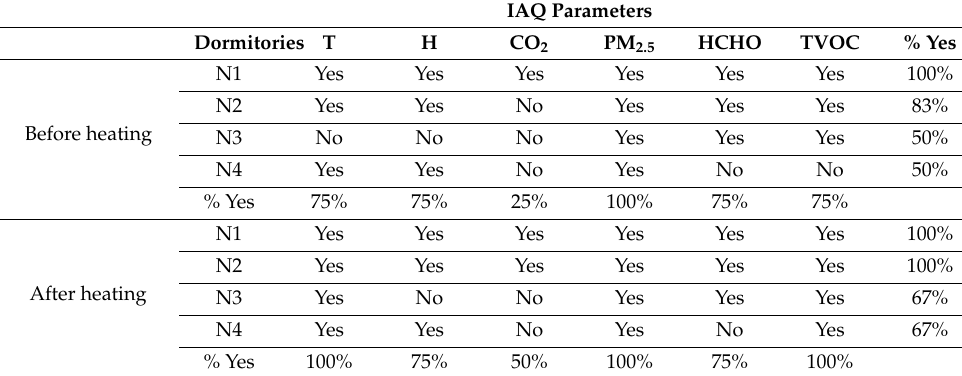
Table 5. Compliance of IAQ for parameters in the studied dormitories with China standard. “Yes” when the parameter is within the acceptable range or “No” if otherwise.